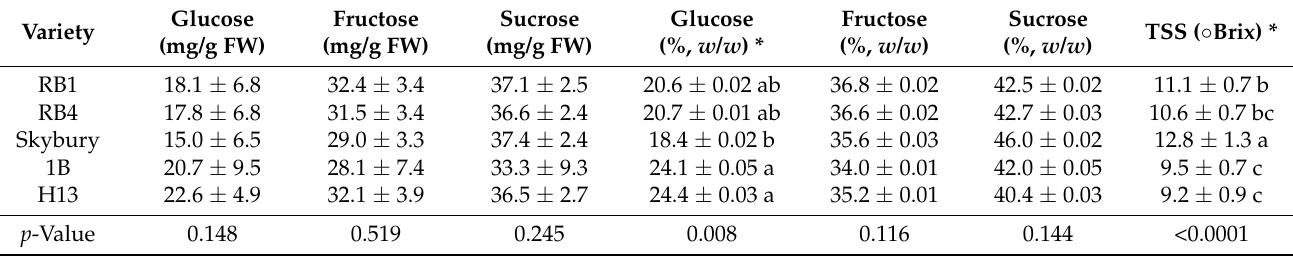
Table 1. Sweetness characteristics from five papaya varieties.